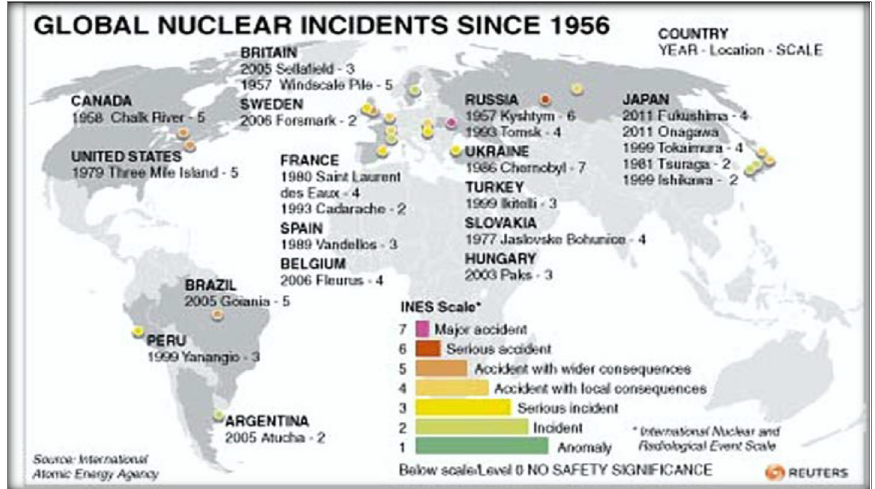
Figure 7. Major nuclear accidents around the world (adapted from